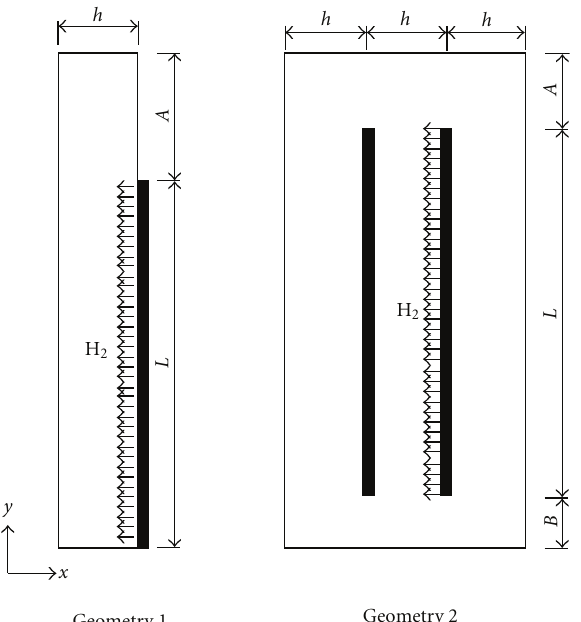
Figure 2: Single-channel geometry (Geometry 1) and triple-channel geometry (Geometry